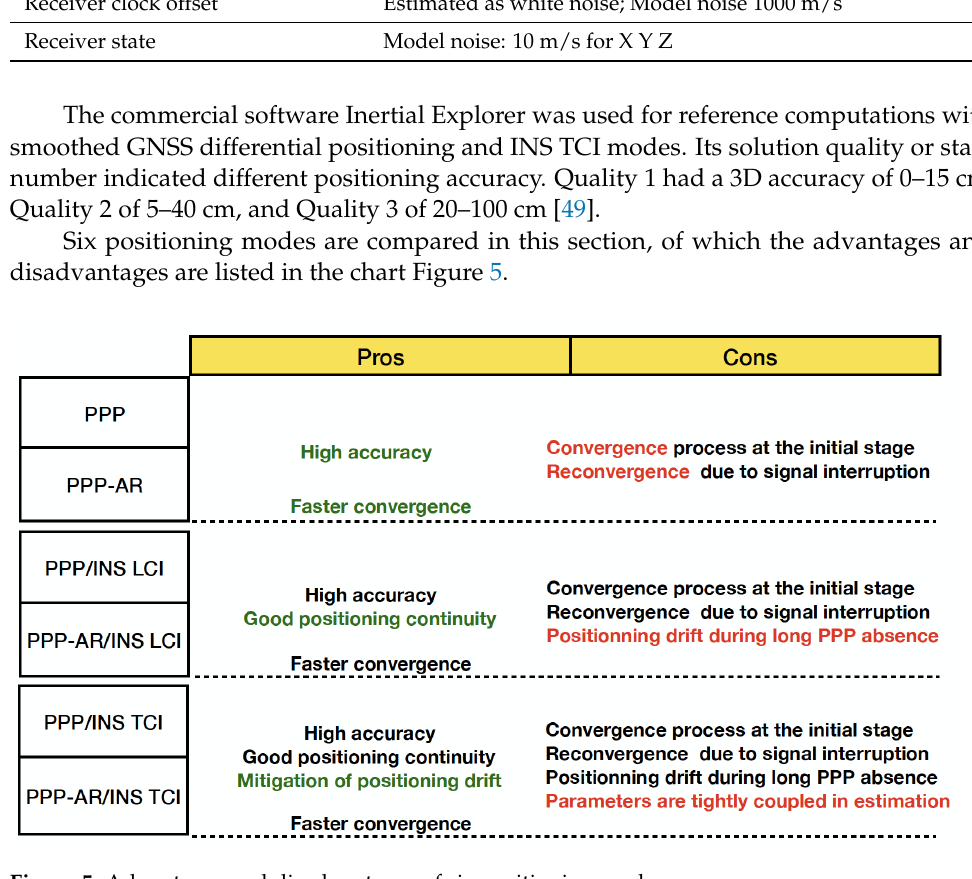
Figure 5. Advantages and disadvantages of six positioning